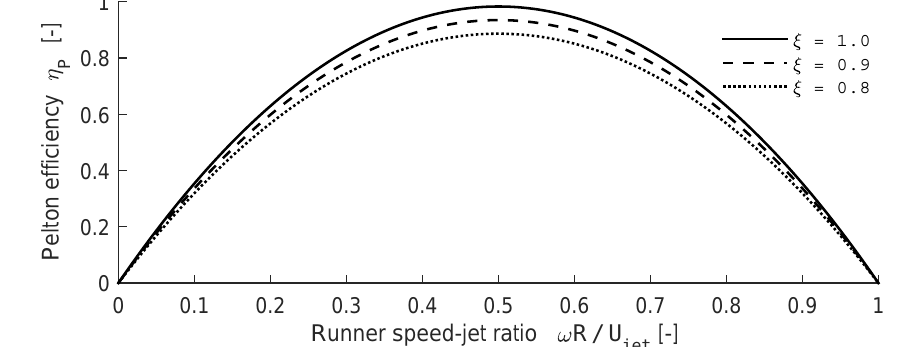
Runner speed-jet ratio R / U